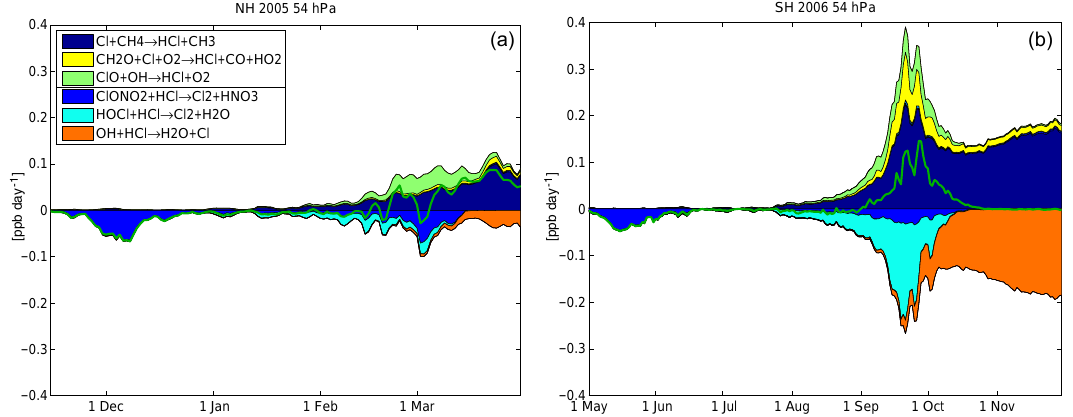
Figure 13. Vortex-averaged chemical reaction rates of reactions involving HCl for the Arctic winter 2004–2005 (a) and the Antarctic winter 2006 (b) at 54hPa. Production reactions are shown as positive and are separated by a line in the legend from the loss reactions, which are shown as negative. The net change of HCl is shown as a green line. Reactions with rates which cannot be distinguished from the zero line at plot resolution are not